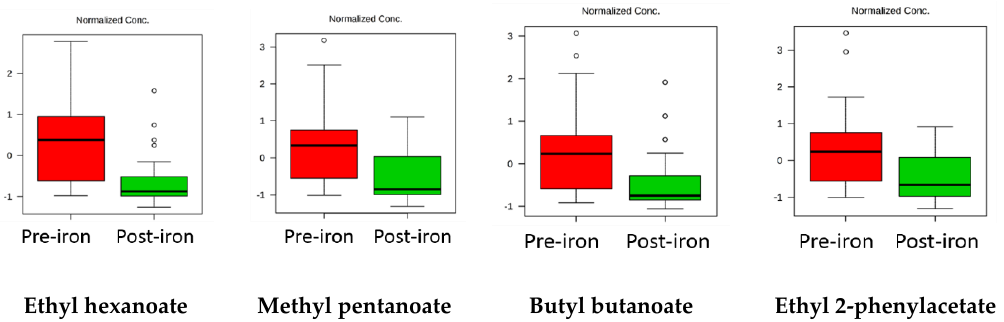
Figure 3. Box and whisker plots show the change in esters in Group